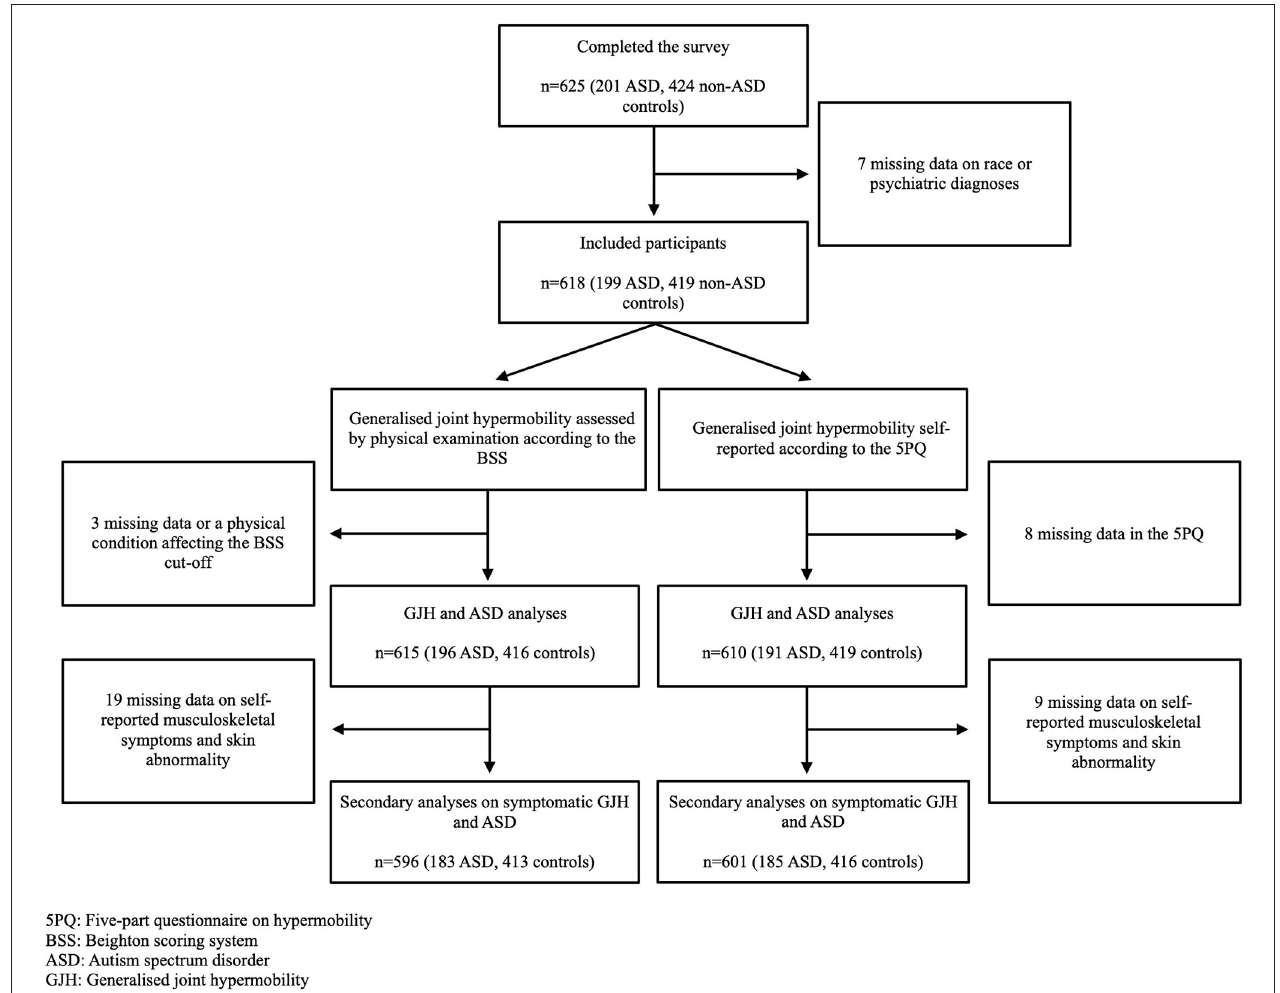
FIGURE 1 | Flow of participants through the